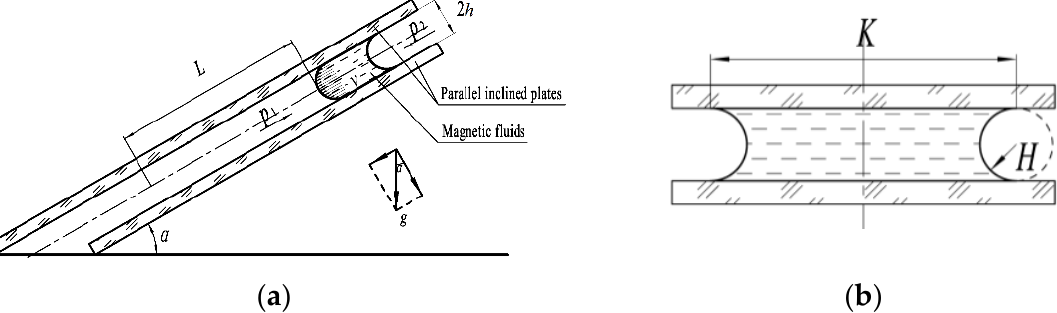
Figure 2. Plane Poiseuille flow diagram: ( a ) the geometry of the problem and ( b ) the parallel inclined plates section [20].